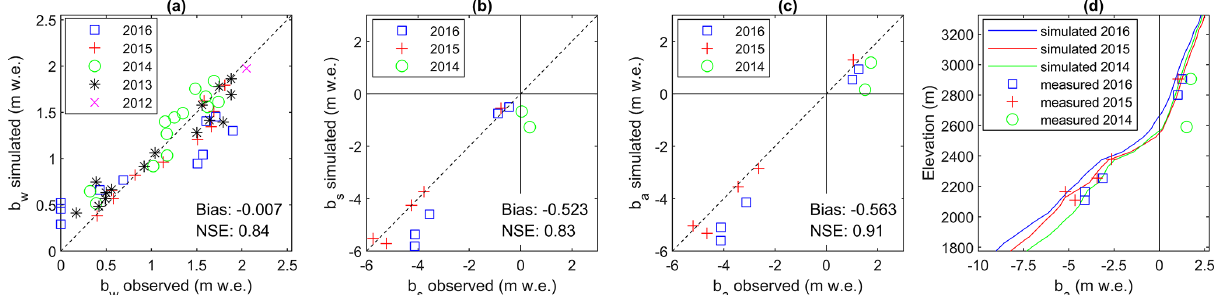
Figure 6. Simulated mass balance compared with point mass balance observations available between 2012 and 2016. (a) Winter balance ( b w ); (b) summer balance ( b s , only available since 2014); (c) annual balance ( b a , since 2014). The dashed line is the 1 : 1 relationship. (d) Simulated vs. observed annual mass balance gradient between 2014 and